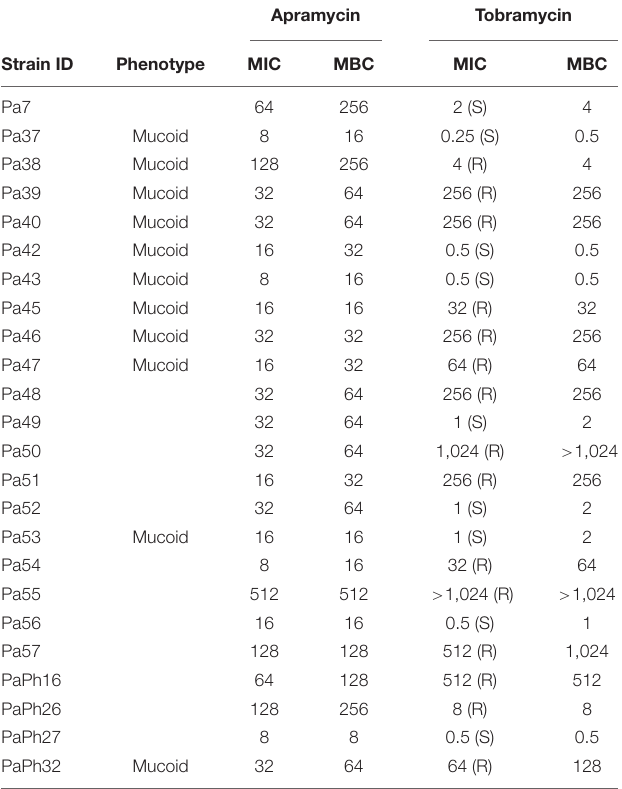
TABLE 1 | Susceptibility of P. aeruginosa CF planktonic cells. Apramycin